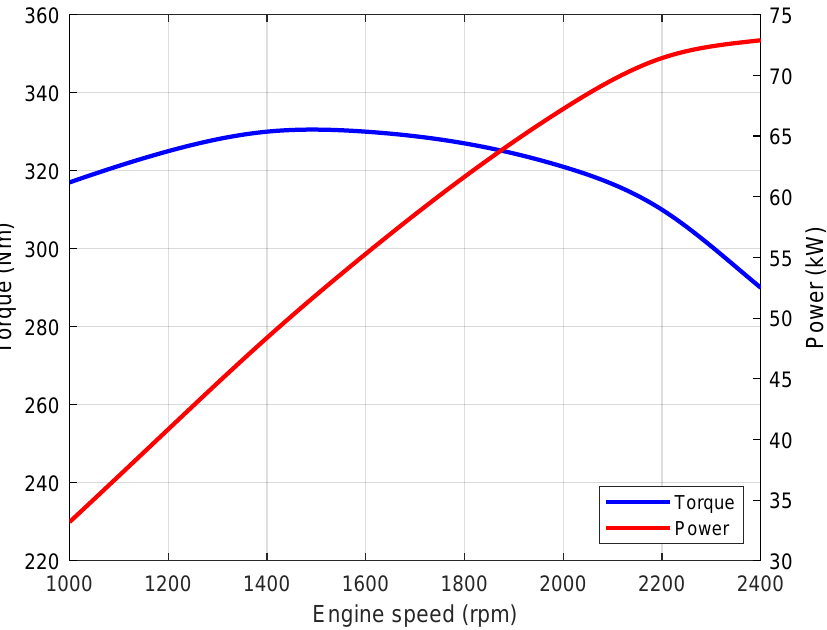
Figure 2. Torque and Power curves of the conventional Diesel engine.